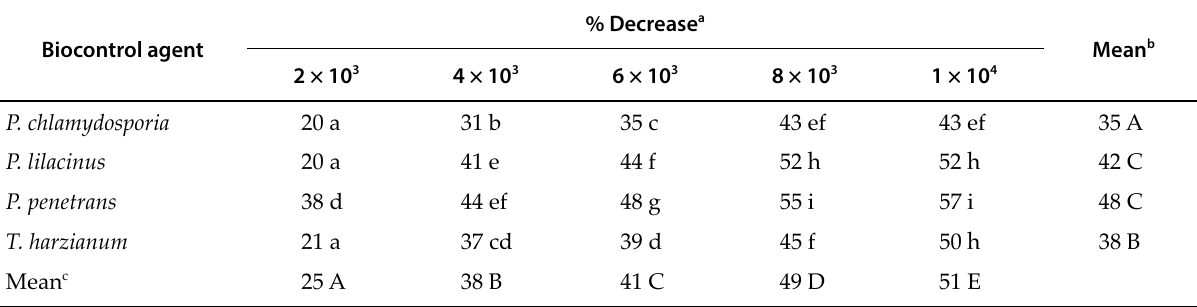
Table 8. Mean proportional decreases in reproductive factors of Meloidogyne incognita after treatments with different nema - tode biocontrol agents applied at different propagule